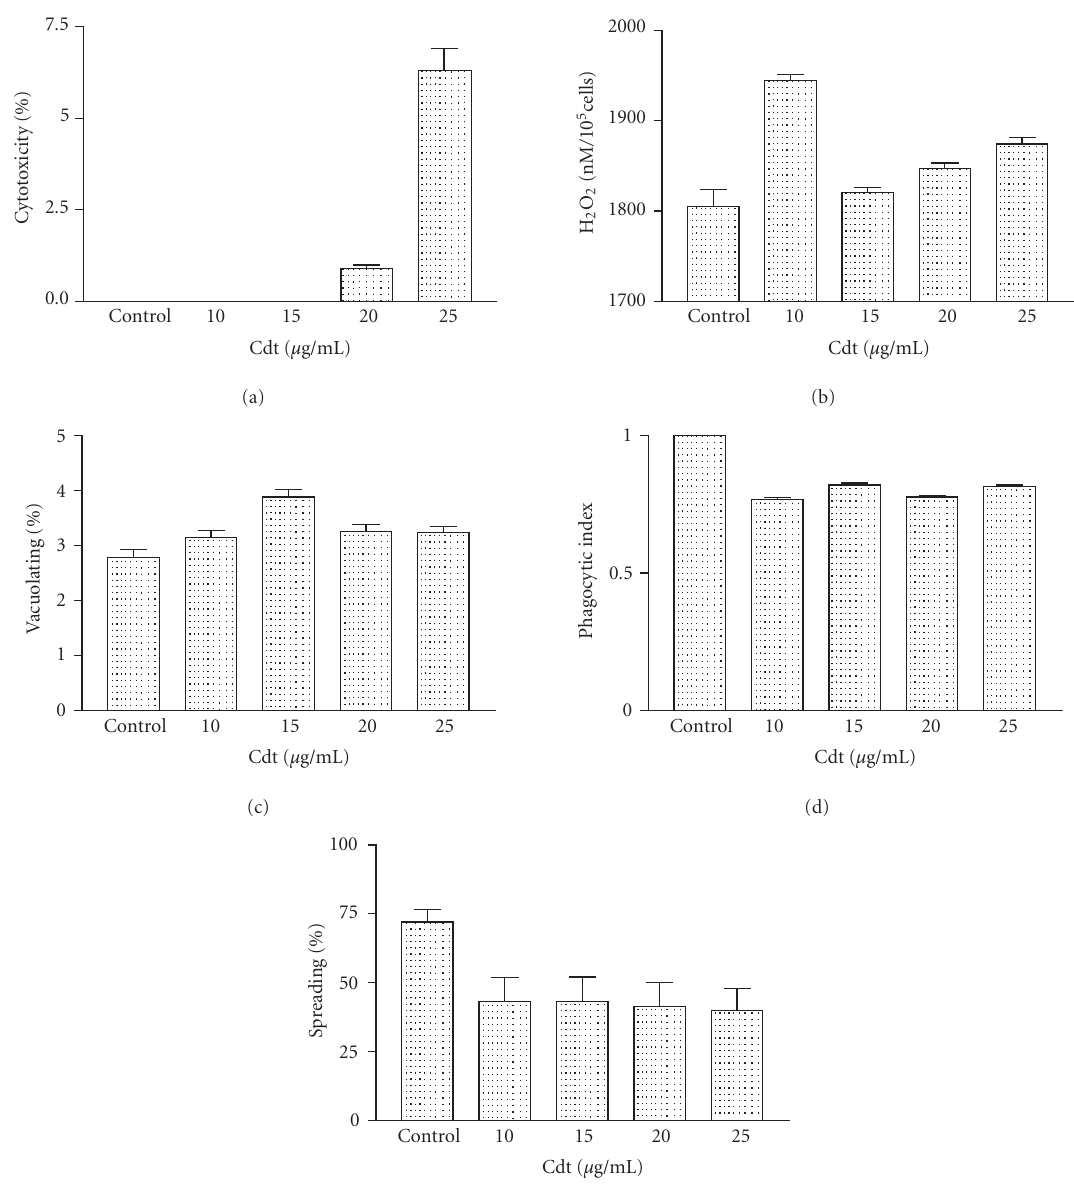
Figure 1. E ff ect of Cdt on macrophage activation. Groups of BALB/c female mice were sacrificed and their peritoneal macrophages collected and exposed in vitro to di ff erent amounts of Cdt. After di ff erent times of incubation of the cultured peritoneal macrophages, the cytotoxic and vacuolating percentages were determined at 24 hours; the levels of H 2 O 2 and phagocytic index were determined at 48 hours; spreading percentage was determined at 12 hours. Each point represents the mean value of samples from five experiments in di ff erent groups of five mice. Statistical di ff erences between the treatments were P > . 01. with L929 cells, a fibroblast continuous cell line was used as described previously by Ru ff and Gi ff ord [30]. The per- centage cytotoxicity was calculated as follows: ( A control − A sample /A control ) ×